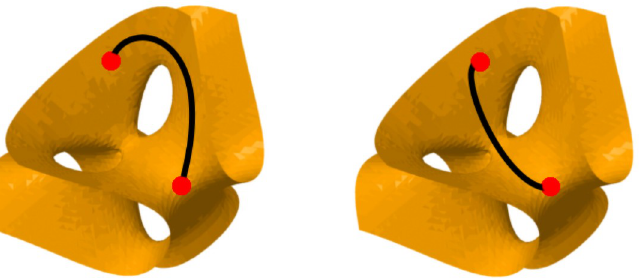
Fig 6. Two different paths connecting two locations within an idealized surface in stereotactic hyperspace (again representing an idealized activated cluster with nontrivial shape). These two paths cannot be continuously deformed into one another without leaving the surface, so these two paths are not homotopic. By tracing one path and then the other, we get a non-contractible loop within the surface of relatively high activation, and consequently a nonzero element in the one-dimensional persistent homology of the fMRI